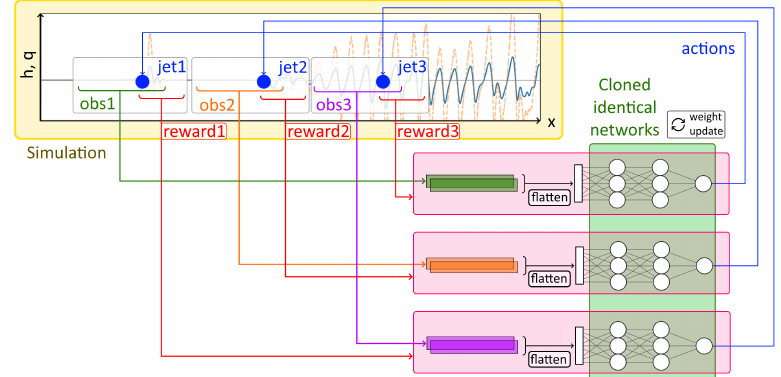
Figure 5. Illustration of the self-collaborative approach demonstrated by Belus et al. [128] for control- ling systems with several similar control outputs. In this method, clones of the DRL agent are used on each of the outputs and share their experience samples and training. This allows us to learn control laws in constant time, independently of the number of outputs used. This figure is reproduced with minor changes from Belus et al.